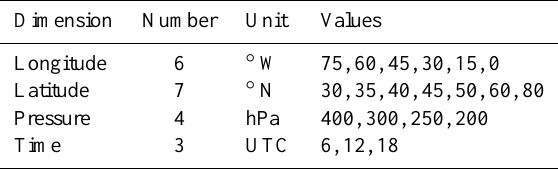
Table 2. Definition of the time-region